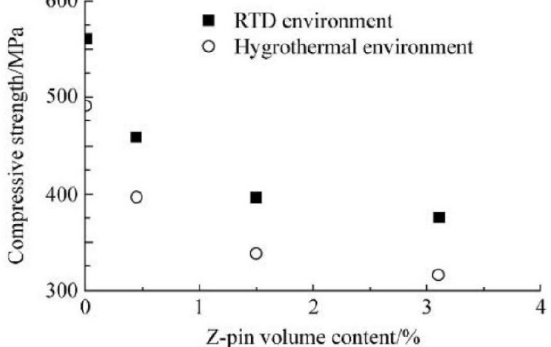
F igure 68. Effect of lay-up on moisture Figure 68. E ff ect of lay-up on moisture absorption ratio of unpinned and z-Pinned laminates [42]. absorption ratio of unpinned and z-Pinned laminates [42].